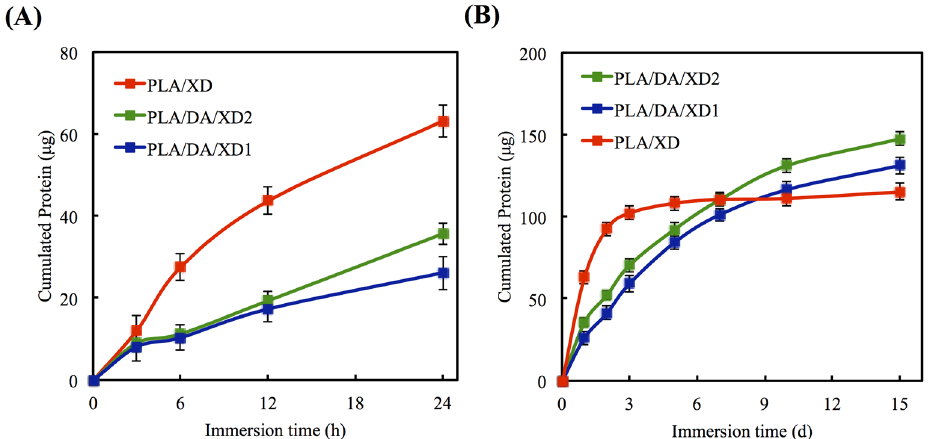
Figure 4. Release profile of XD from PLA scaffolds in DMEM for ( A ) short and ( B ) long times. The values shown are means ± standard errors for all the